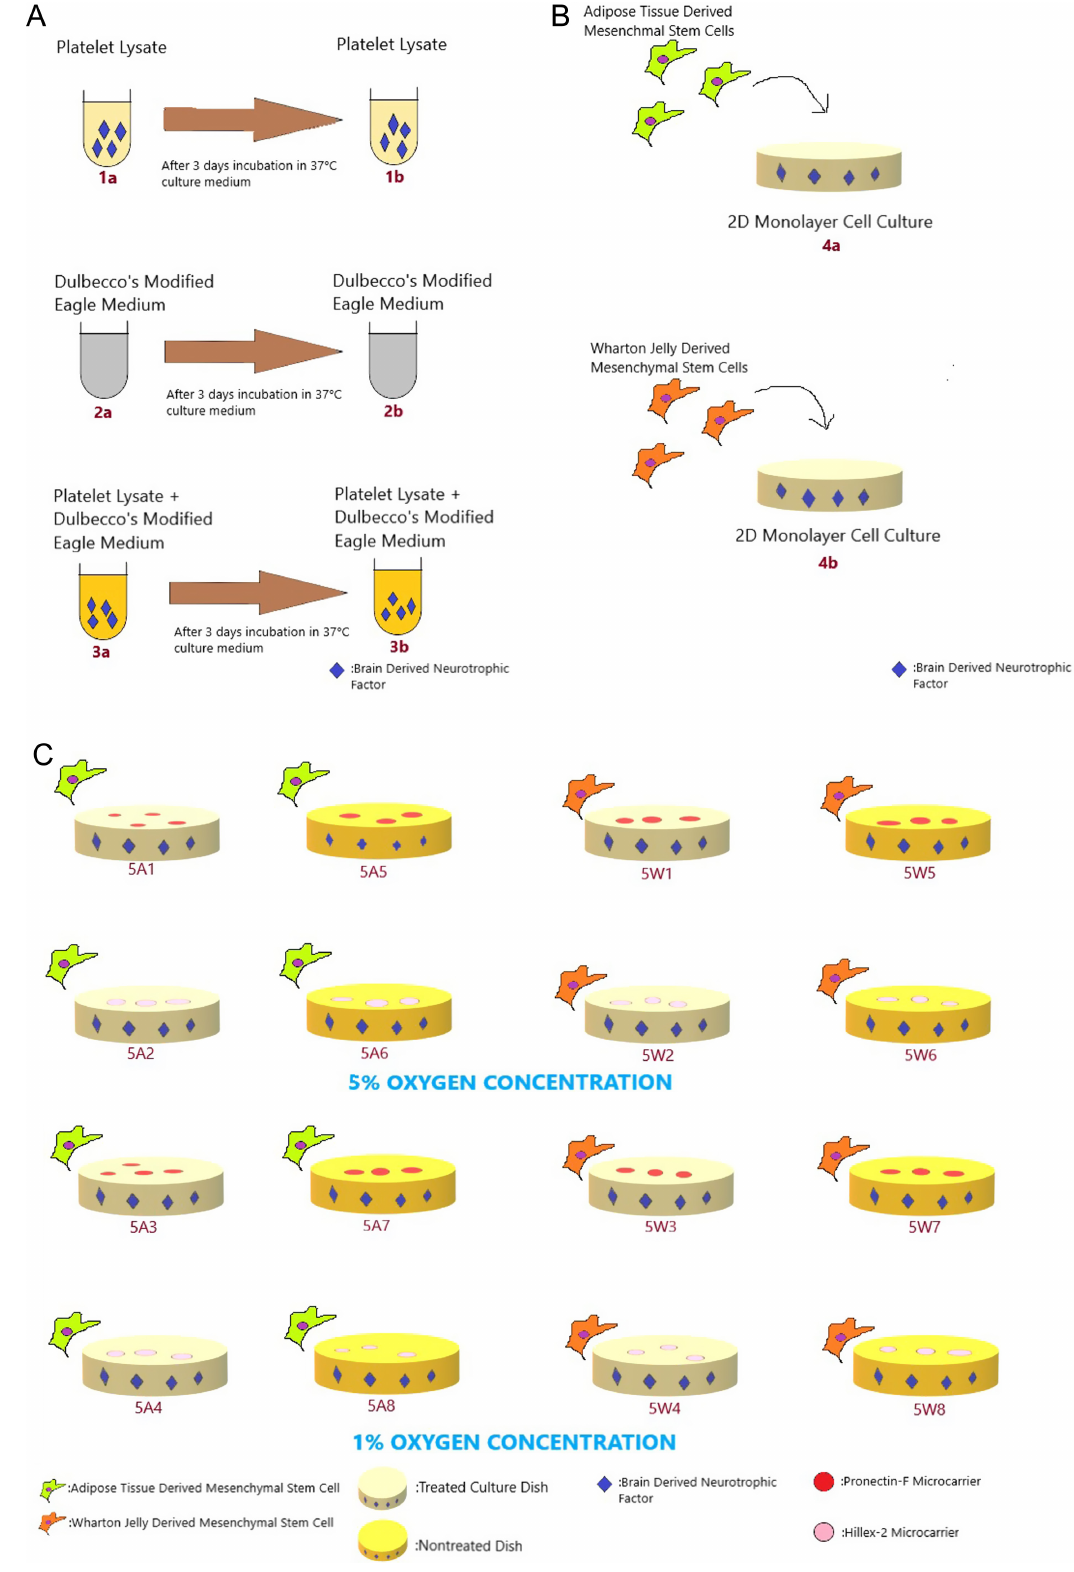
Figure 2. A-C. Amounts of BDNF were measured in each group in pictures A, B, and C (1a, 1b, 2a, 2b, 3a, 3b, 4a, 4b, 5A1, 5A2, 5A3, 5A4, 5A5, 5A6, 5A7, 5A8, 5W1, 5W2, 5W3, 5W4, 5W5, 5W6, 5W7, 5W8). BDNF, brain-derived neurotrophic